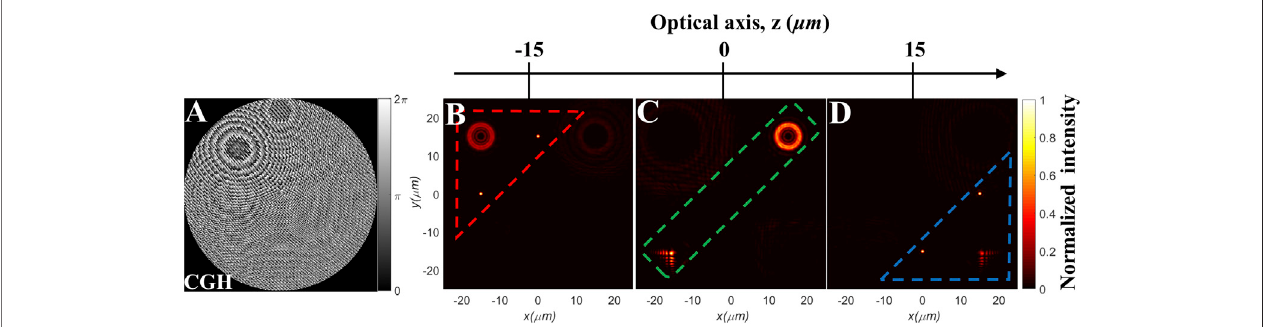
FIGURE7 | Thegenerated hybrid optical traps at different axial positions. (A) Hologram. (B) A PV +5 and two GPsinside thered dashed line, located in the plane of z (cid:1)− 15 μ m. (C) APV -5 and an Airy beam inside the green dashed line, located in theplane of z (cid:1) 0. (D) An Airy beam and two GPsinside the blue dashed line, located in the plane of z (cid:1) +15 μ m.